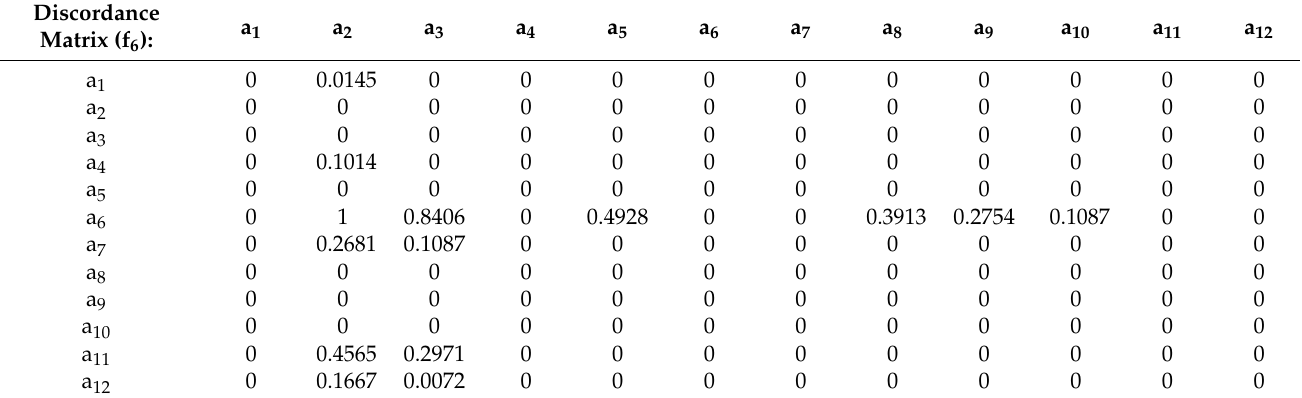
Table A6. Values of the non-compliance indicators according to the 6th